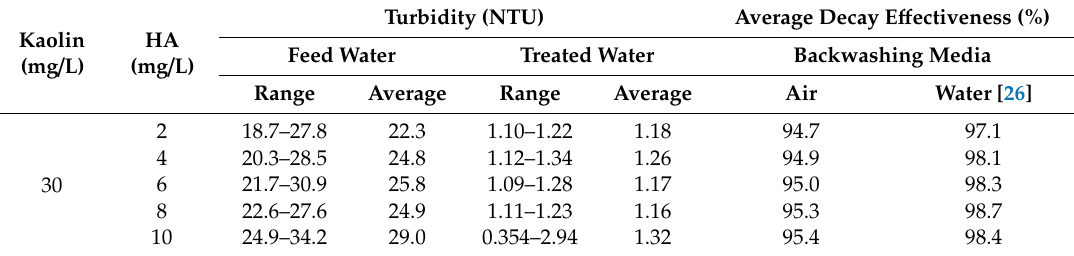
Table 7. Decay e ff ectiveness of turbidity for e ff ect of humic acid in the integrated system, of multichannel ceramic MF and pure PP particles, using air backwashing (FT 10 min, BT 10 s); paralleled with outcomes of water backwashing.